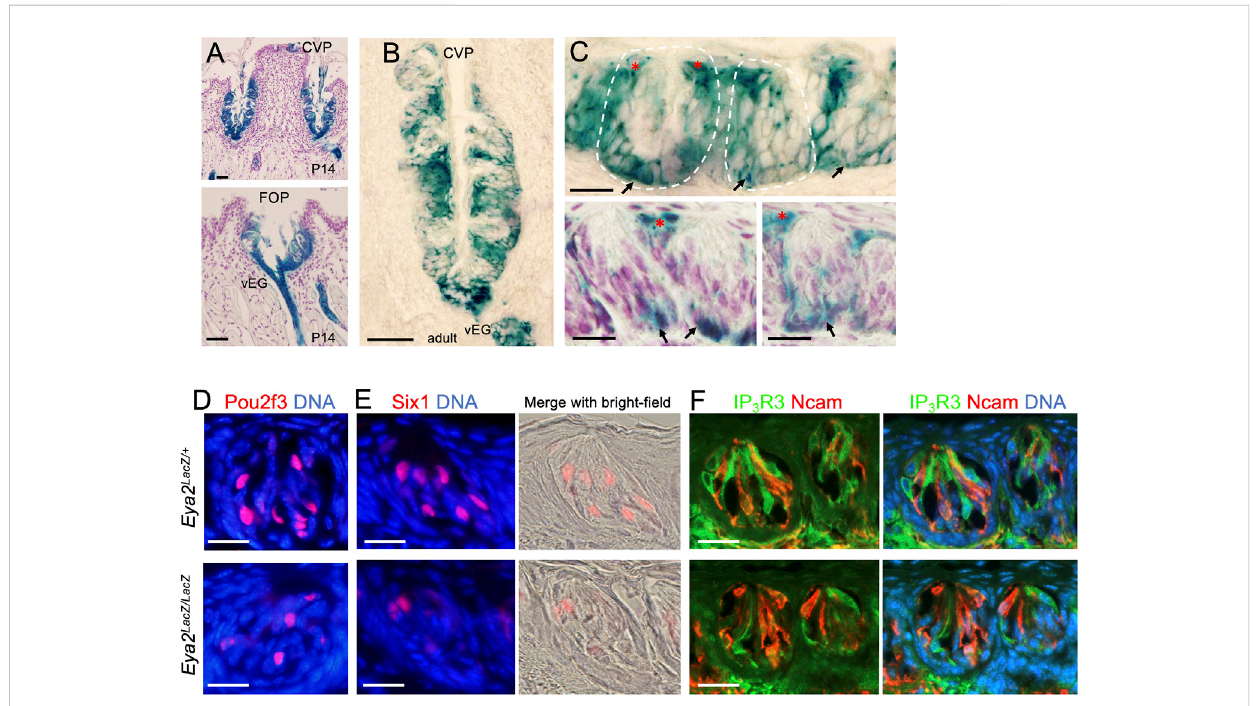
FIGURE 8 Eya2 is expressed in the CVP and FOP taste buds, and Eya2 -de fi cient mice show a reduced number of Type II taste cells. (A, B) X-Gal staining on sections showing broad expression of Eya2 LacZ in the CVP and FOP trench epithelium at P14 (A) and the adult CVP trench epithelium (B) . (C) Higher magni fi cationshowing β -Gal + cellsinsomebasalprogenitors(arrows)andcellssurrounding thetastepore(redasterisks)andinside thetastebuds.Some sections were counterstained with diluted hematoxylin (A and two lower panels in (C) . (D – F) Immunostaining for Pou2f3 (D) , Six1 (E) , and co- immunostaining for IP 3 R3/Ncam (F) in wild-type control and Eya2 -de fi cient adult taste buds. Scale bars: 50 μ m (A, B) and 20 μ m (C – E)